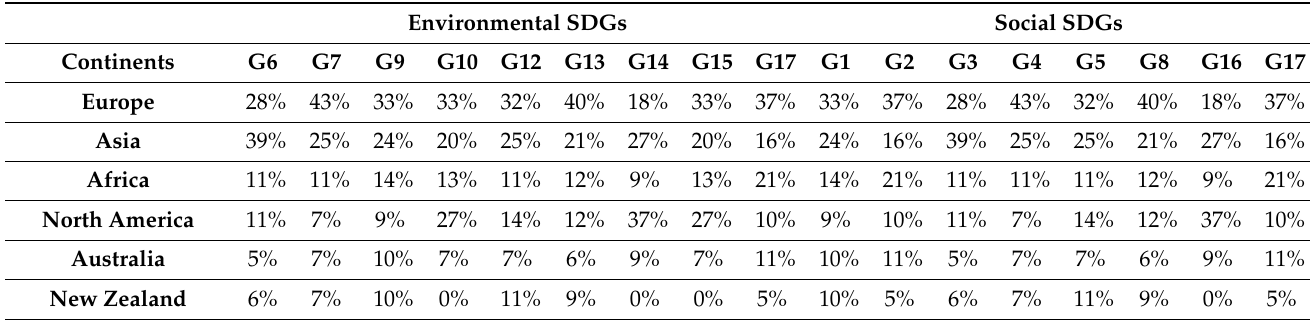
Table A2. Practice of Environmental and Social